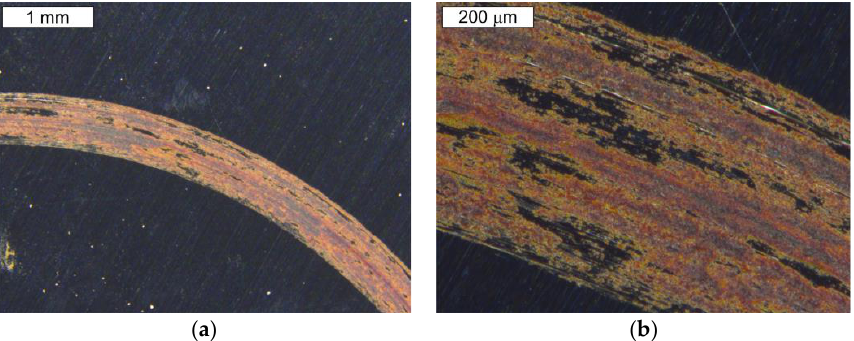
Figure 10. View of: ( a ) a stereoscopic image of the friction face for steel Hardox 600 and ( b ) a magnified fragment from the area in Figure 10a. Stereoscopic microscopy.